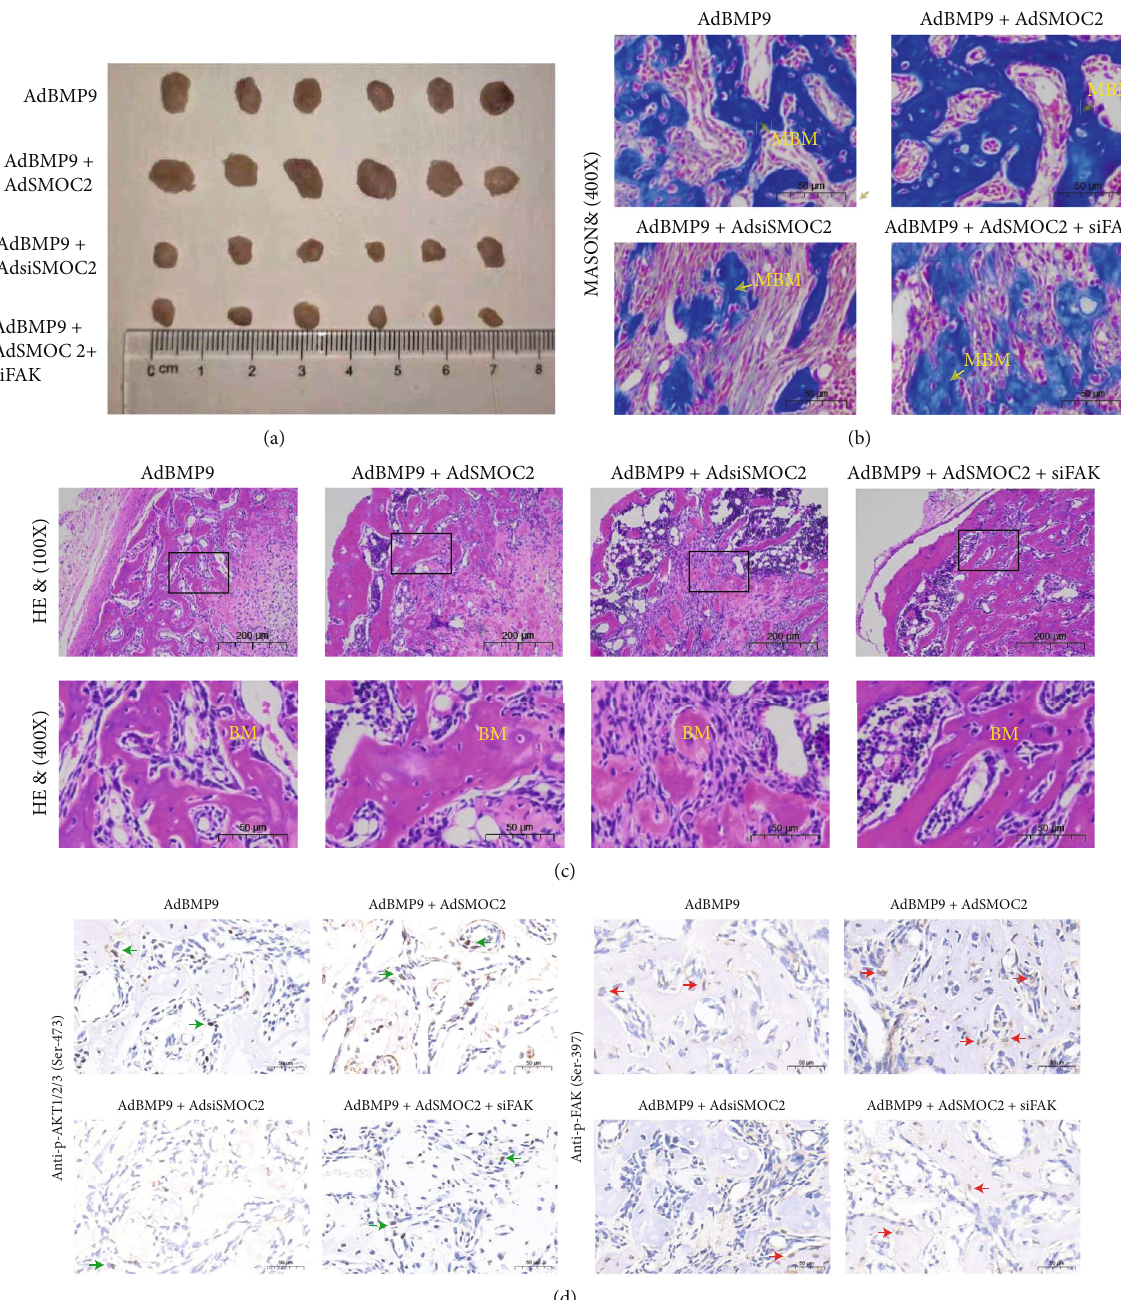
Figure 5: SMOC2 potentiates BMP9-induced ectopic bone formation in MEF implantation in vivo, while knockdown of FAK inhibits bone formation. (a) Macrographic images of ectopic bone mass. MEFs were implanted subcutaneously after infection with the designed adenoviruses. Ectopic osseous masses were retrieved at 4 weeks. Representative images are shown. (b) Masson ’ s trichrome staining results showed the e ff ect of SMOC2 and FAK knockdown on BMP9-induced ectopic bone masses in MEFs (scale bar is 50 μ m for the panel). (c) Hematoxylin-eosin (H&E) staining results showed that the osteogenesis ability was a ff ected by SMOC2 and/or FAK knockdown in MEFs (scale bar is 200 μ m for upper panel and 50 μ m for lower panel). (d) Immunohistochemical staining results showed the expression relationship between p-FAK and p-AKT1/2/3. Ectopic osseous masses were retrieved at 4 weeks. The expression of p-FAK and p-AKT1/2/3 was assessed by immunohistochemical staining analysis. Representative images are shown (scale bar is 50 μ m for the